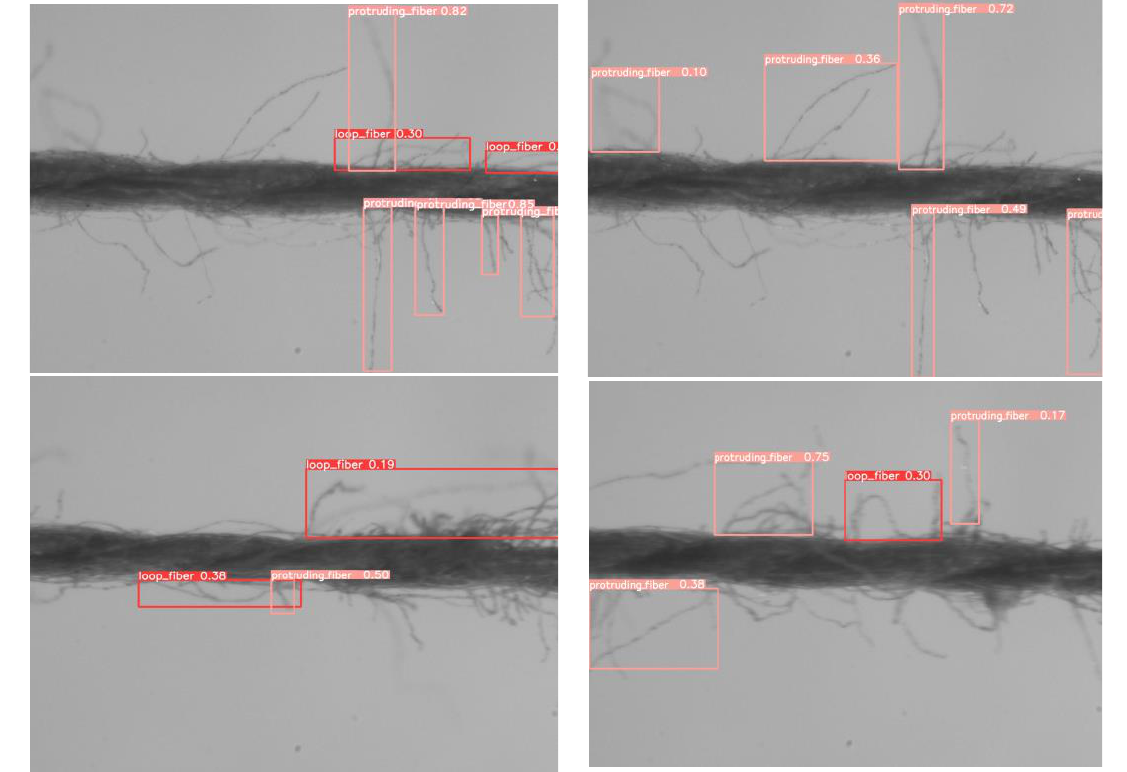
Figure 46. Classification results using the YOLOv5s algorithm.